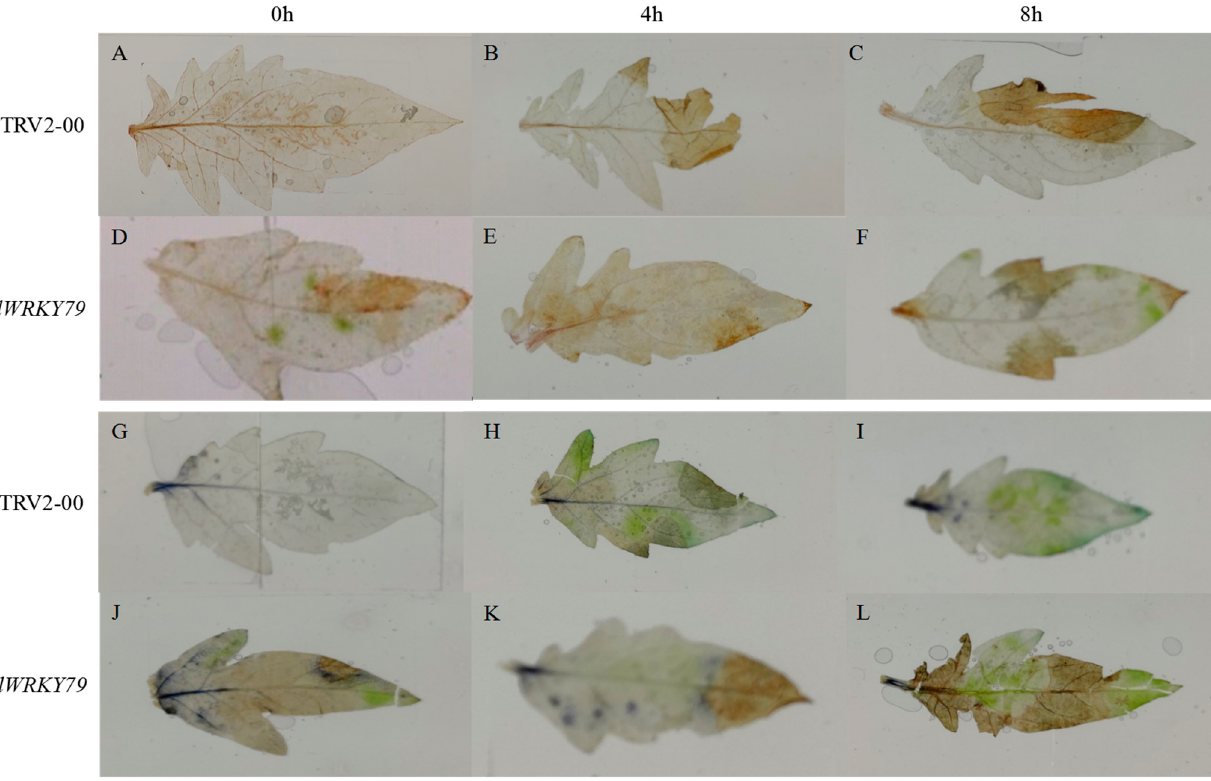
Figure 6. After salt treatment, H 2 O 2 and O 2 − accumulation in leaves increased with increasing time. ( A – F ), H 2 O 2 accumulation indicated by DAB staining; ( G – L ), O 2 − accumulation indicated by NBT staining.